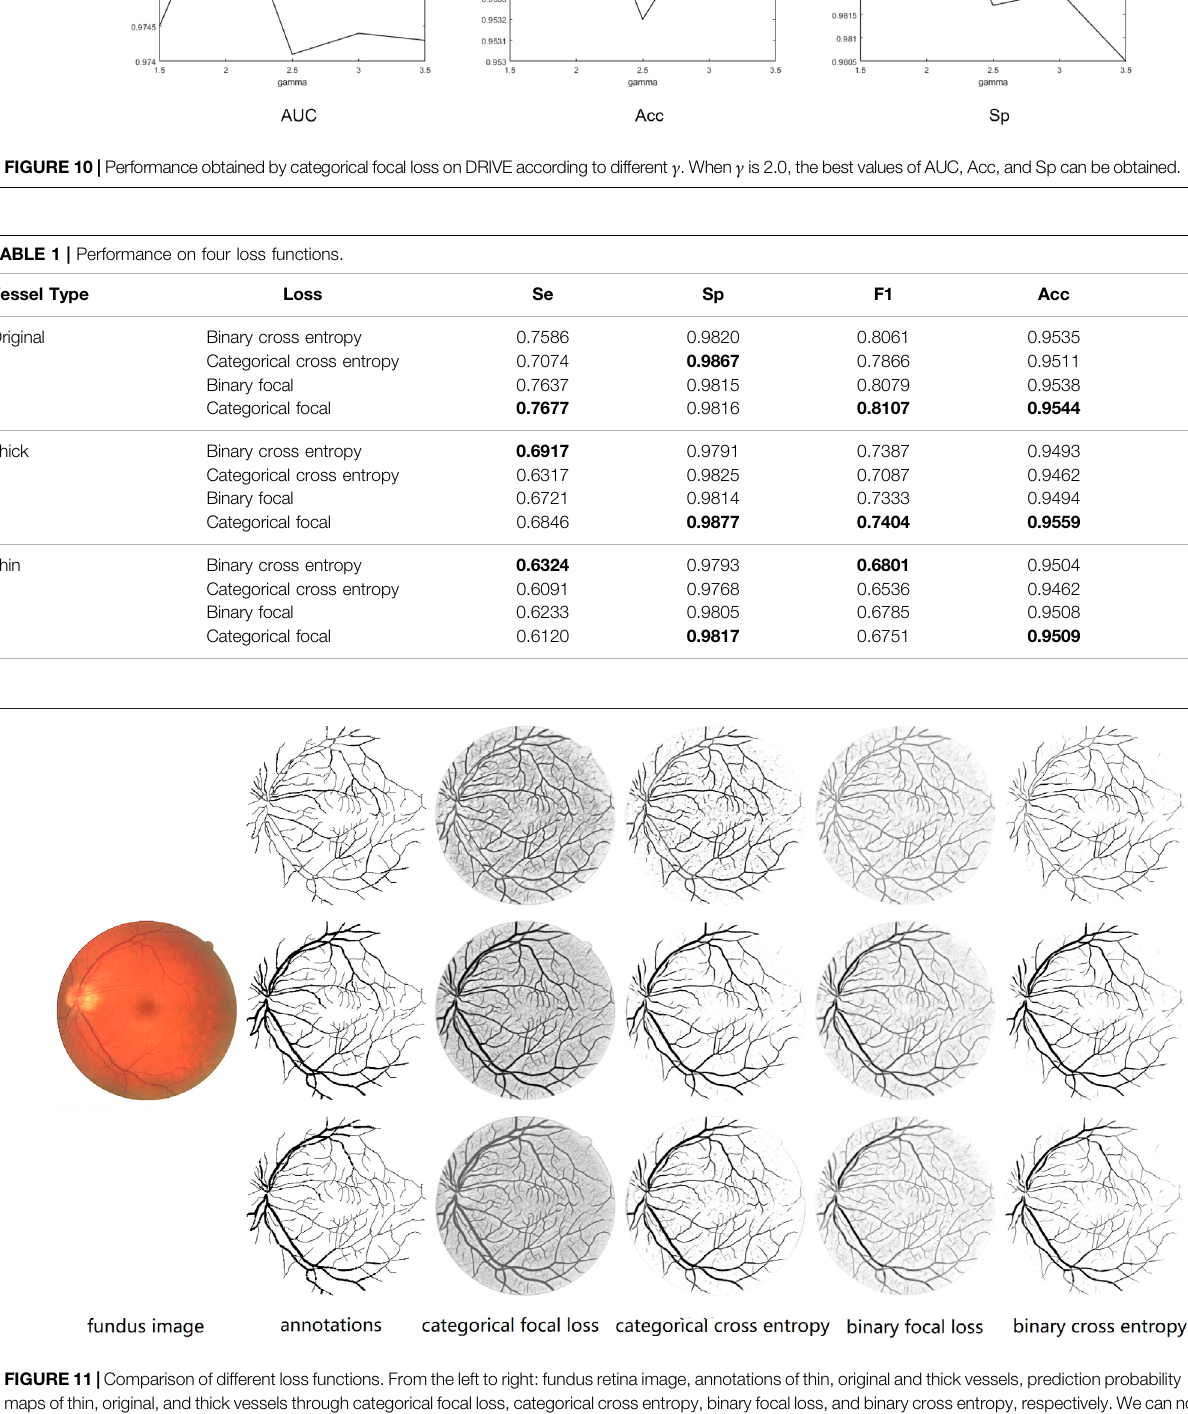
Frontiers in Bioengineering and Biotechnology |